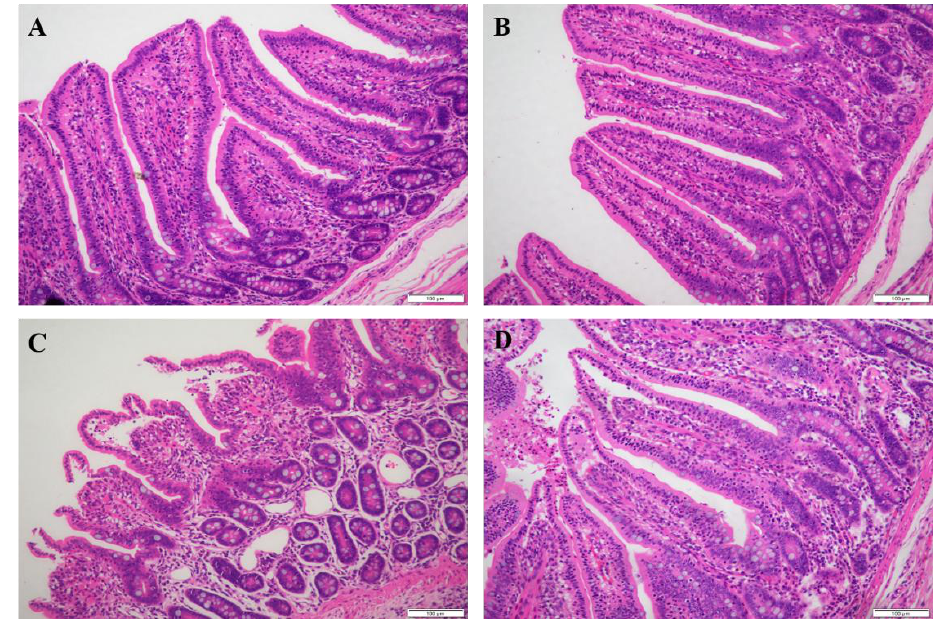
from Ilex latifolia Thunb.; SEM, standard error of mean.